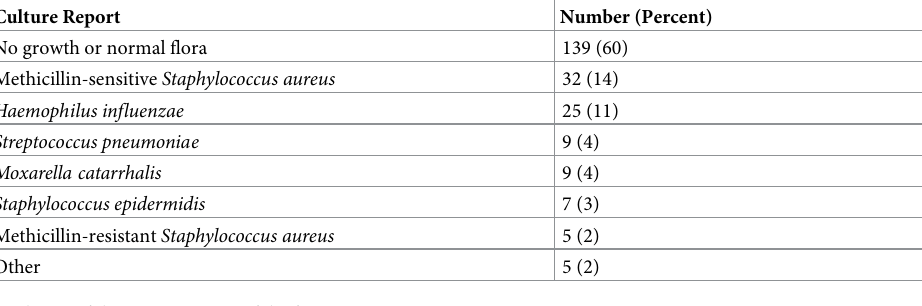
Table 7. Bacterial colonization (cid:3)